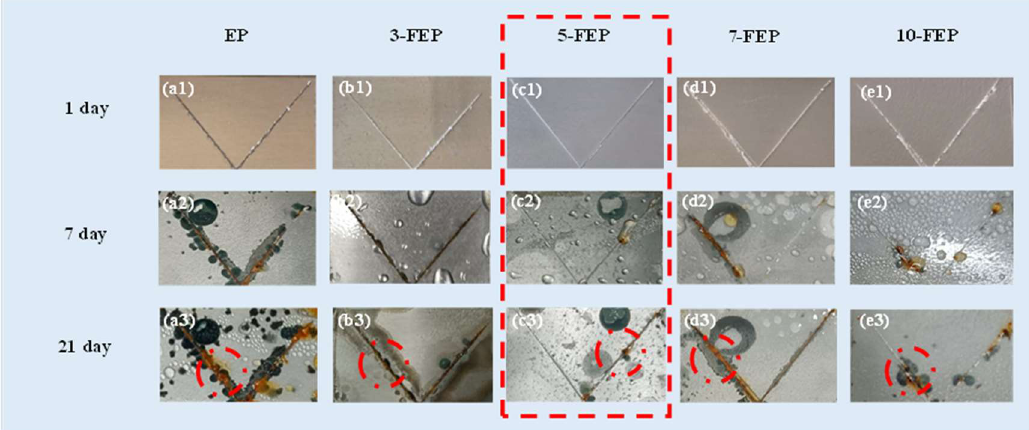
Figure 14. Visual surface images of the composite coating after exposure to salt spray test for 1, 7 and 21 days.